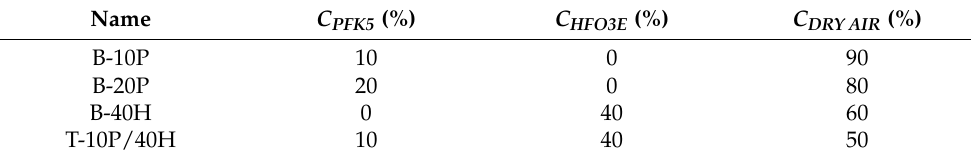
Table 3. Nomenclature and concentration ( C ) of the components of the studied gas